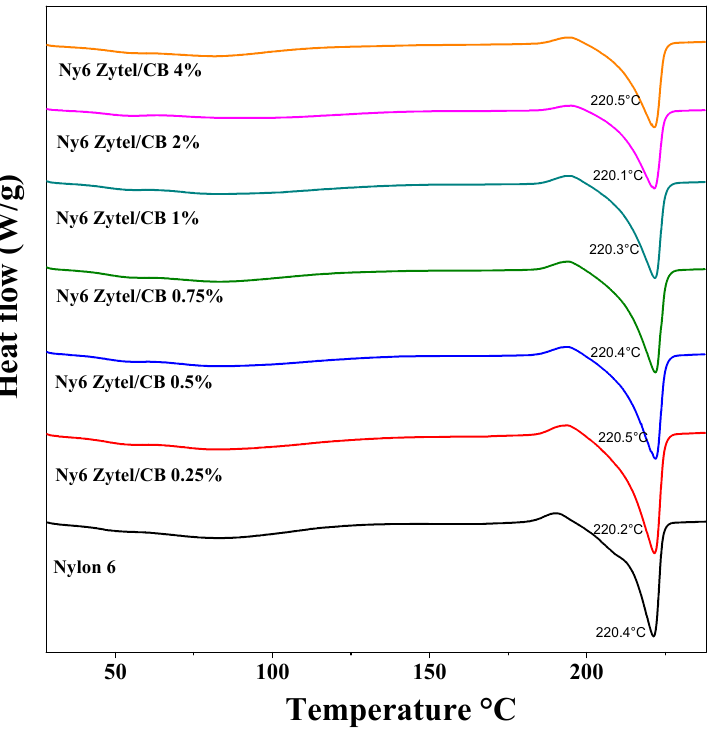
Figure 5. Melting endotherms obtained by DSC from Nylon 6 nonwoven fabrics and Ny6 Zytel/CB nonwoven fabrics at different concentrations (0.25, 0.5, 0.75, 1.0, 2.0, and 4.0 wt.%).